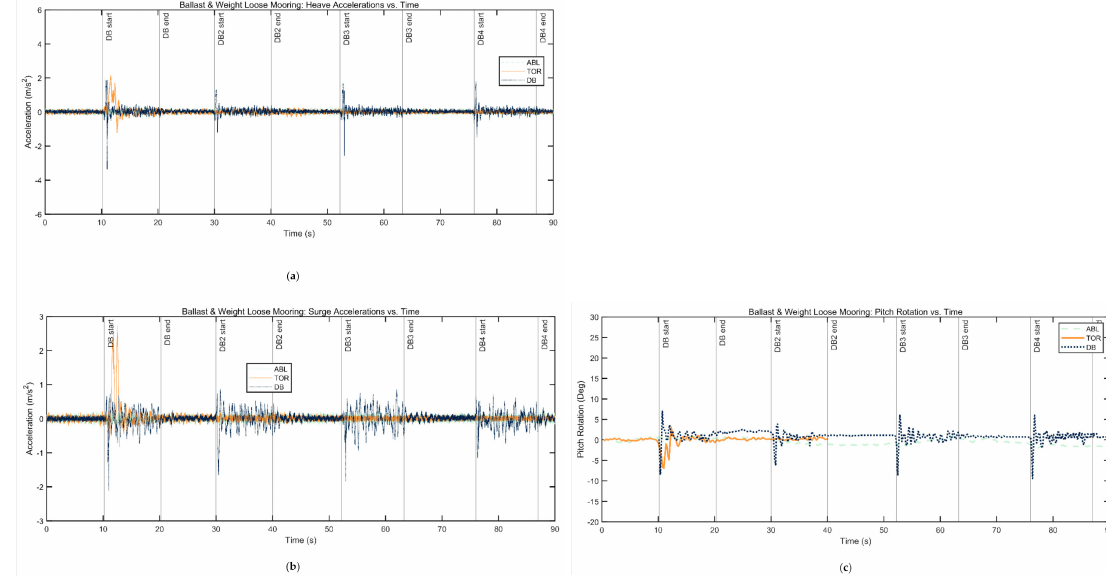
Figure 15. ( a ) Heave acceleration, ( b ) Surge acceleration, and ( c ) Pitch rotation of Configuration 4-Loosely moored ballasted platform with added top-heavy